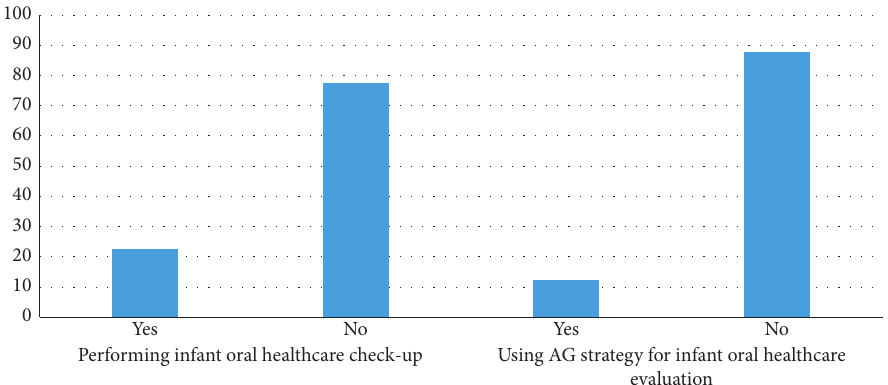
Figure 1: Distribution of dentists’ attitude towards infant oral healthcare and AG ( N �